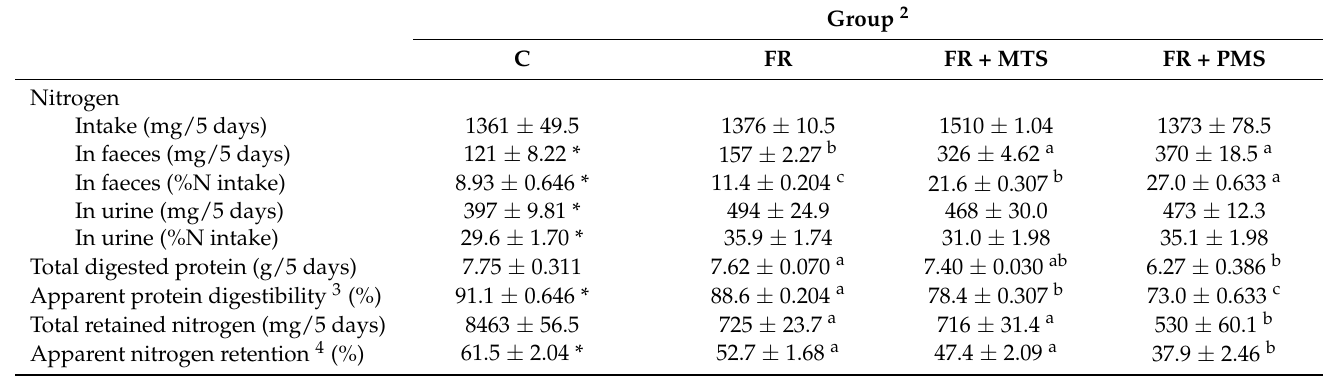
Table 2. Nitrogen balance, protein digestibility and nitrogen retention in rats fed a fibre-rich (FR) diet containing milk thistle seeds (MTSs) or pot marigold seeds (PMSs) 1